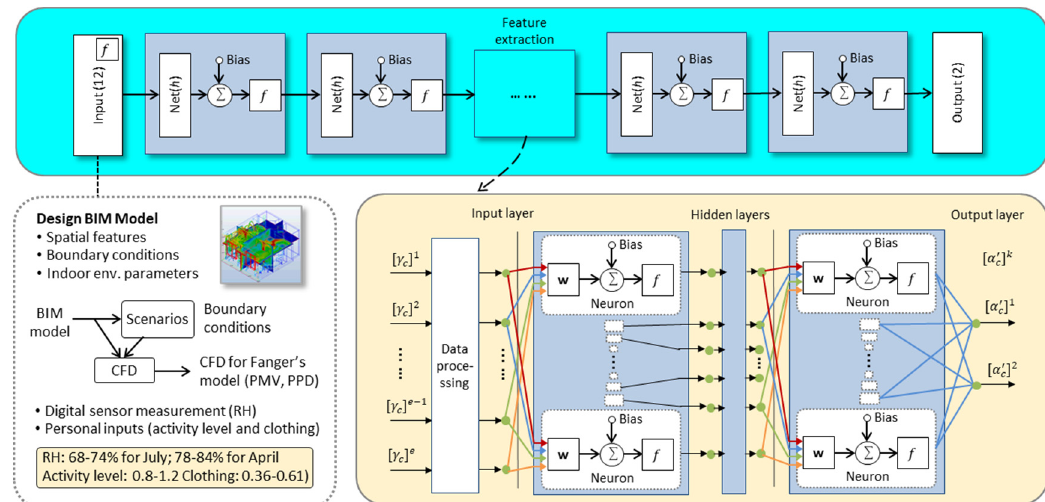
Figure 4. Data-driven model for predictive analysis of thermal comfort.